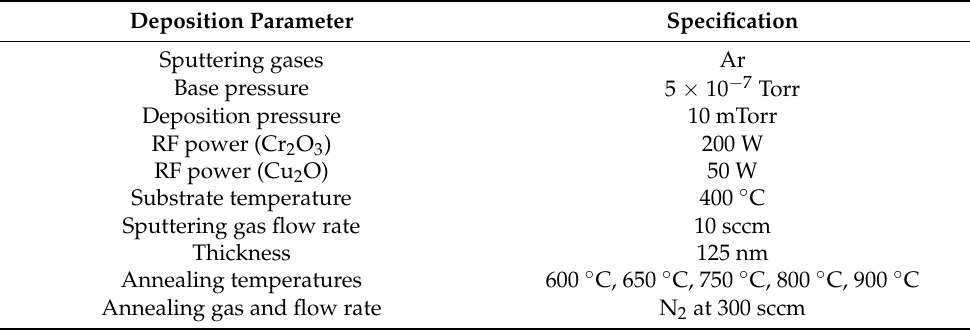
Table 1. Deposition parameters maintained during deposition of CuCrO 2 thin